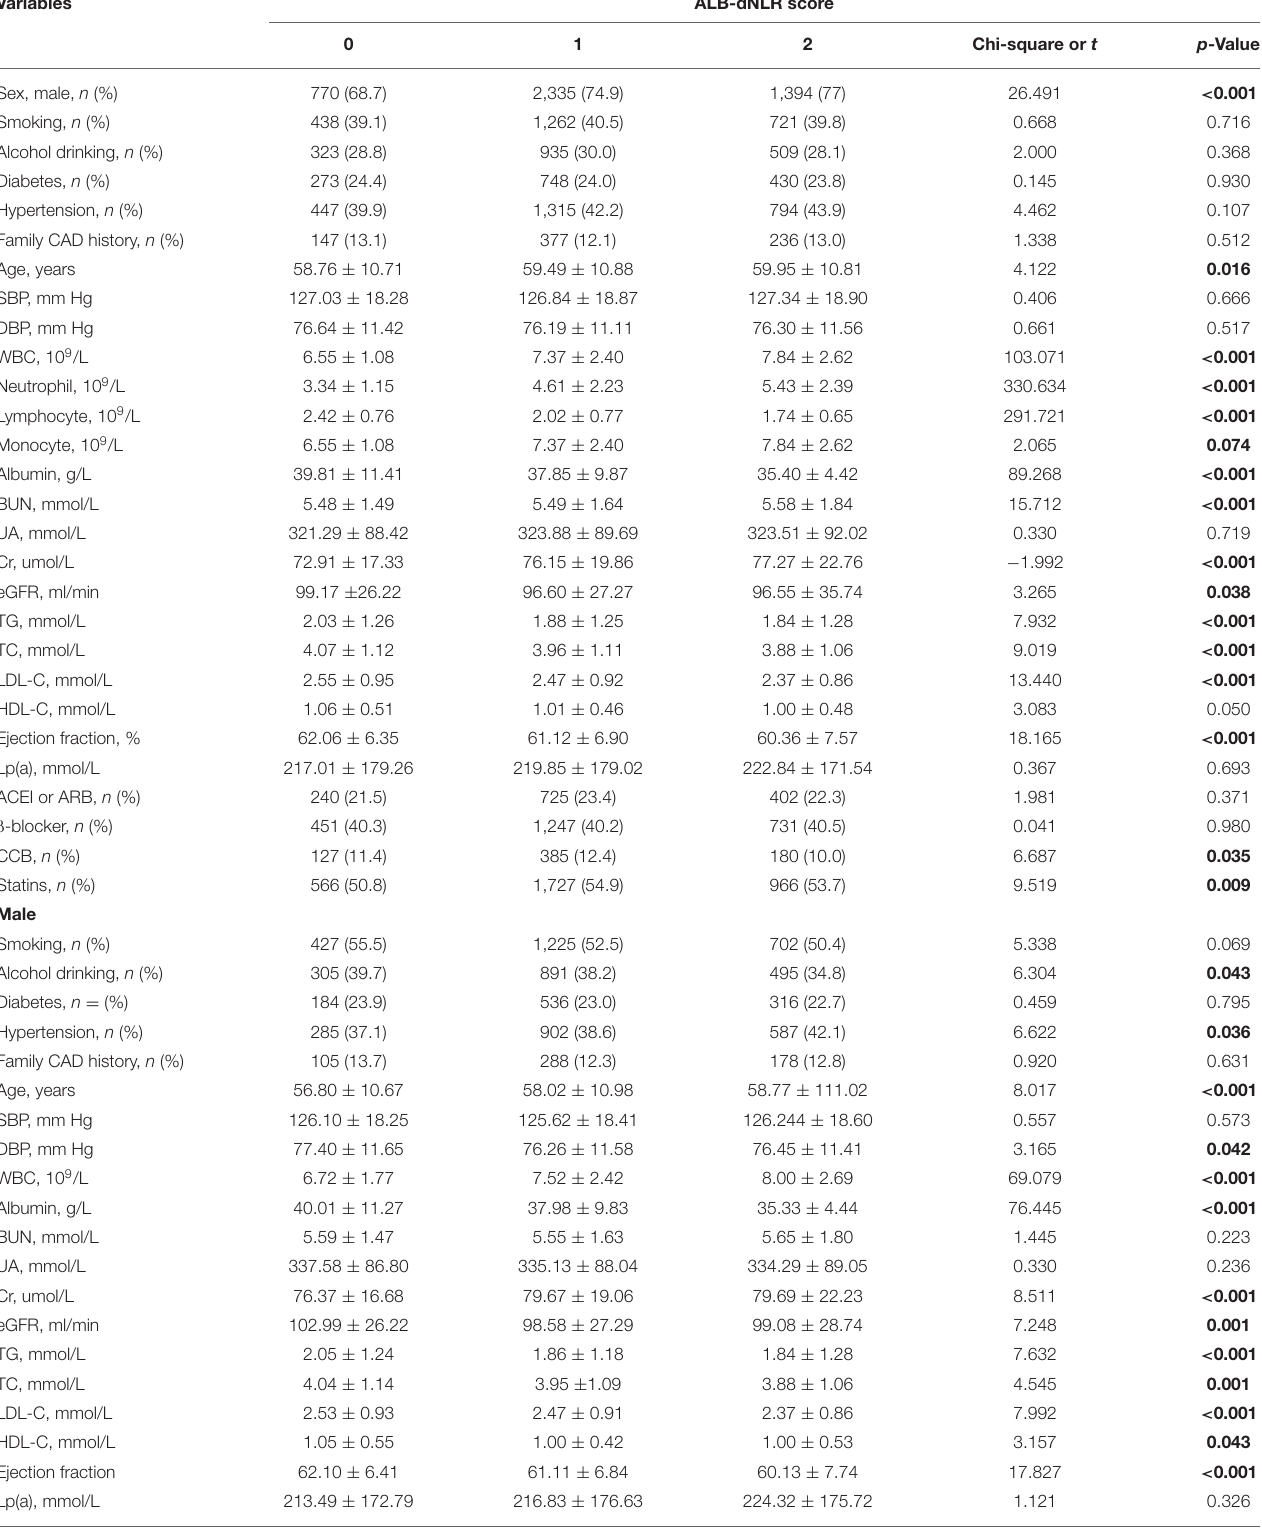
TABLE 1 | Characteristics of participants of the three groups.